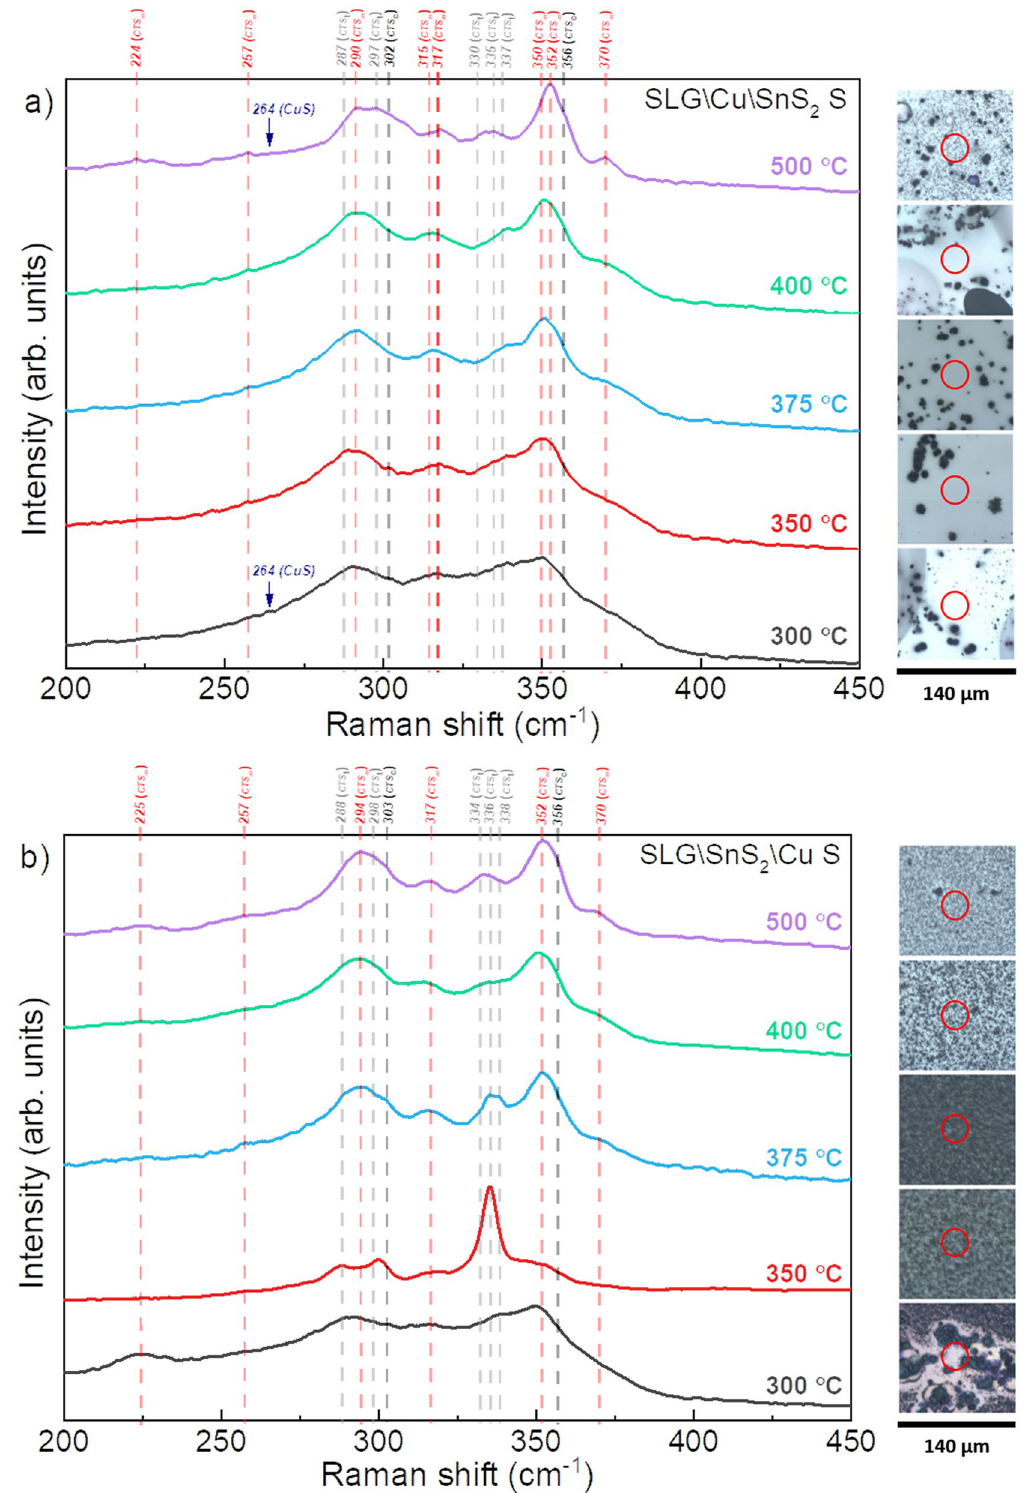
Figure 5. Raman spectra of the CTS films annealed under S atmosphere at different temperatures, measured using a 633 nm wavelength. ( a ) SLG\Cu\SnS 2 and ( b ) SLG\SnS 2 \Cu stacks. The dashed vertical lines represent the Raman shifts of all identified or possible phases. On the right side, the relative optical images with the measured spot for each sample are